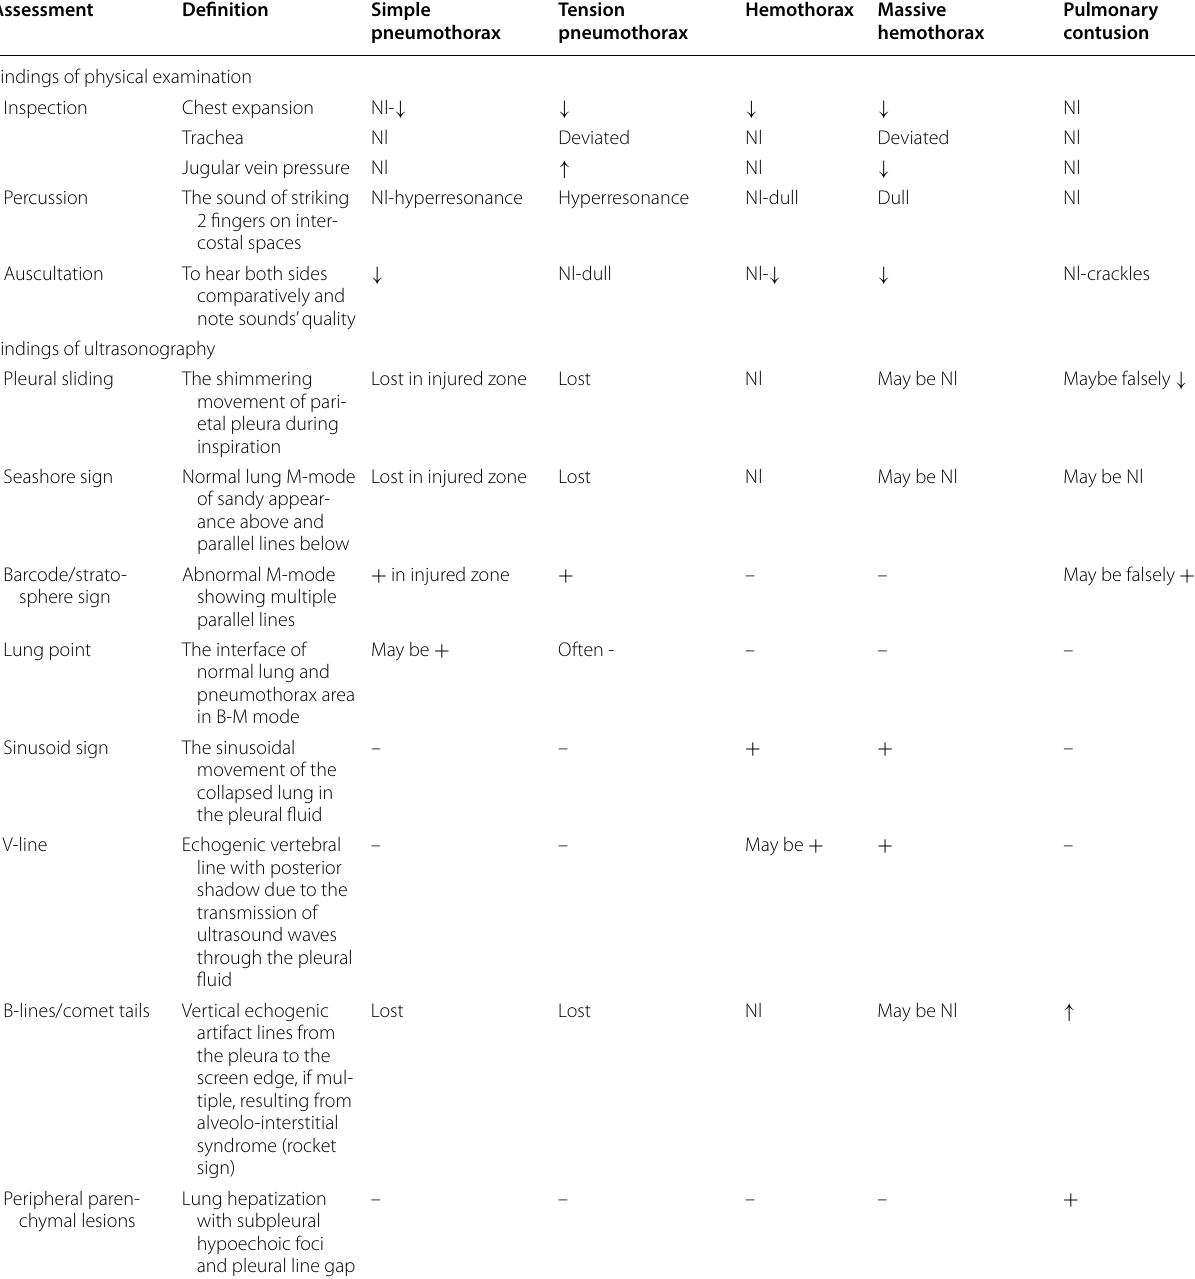
Table 1 The diagnostic findings applied to assess traumatic chest injuries in physical exam and